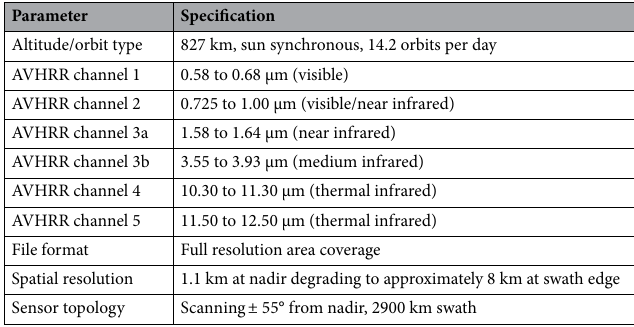
Table 1. Selected specifications for the MetOp-A AVHRR sensor.